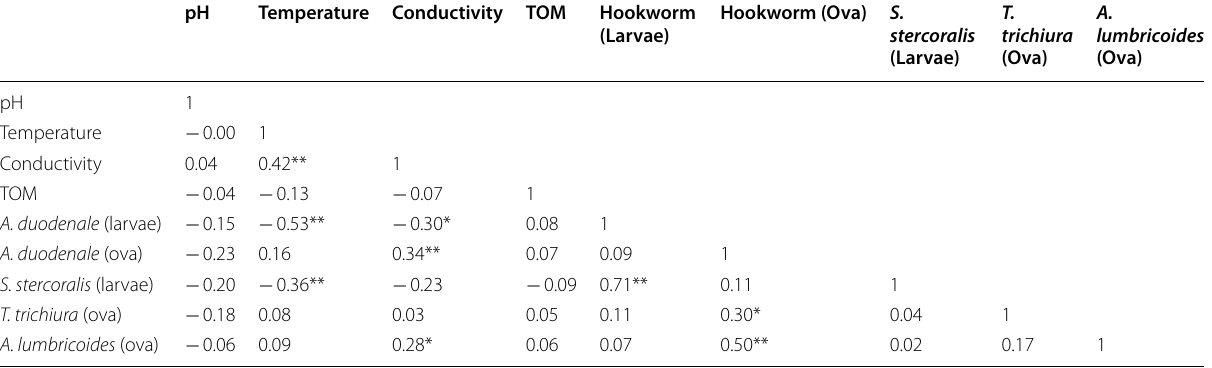
TOM total organic matter *Correlation is significant at the 0.05 level (2‑tailed) **Correlation is significant at the 0.01 level